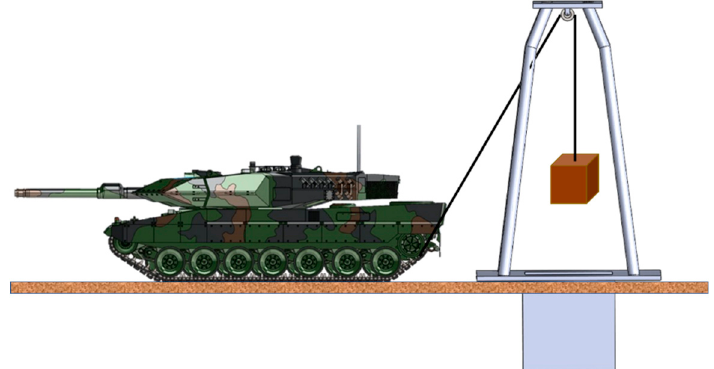
Figure 2. Schematic for the installation for measuring the moments of inertia of the transmission of a tracked vehicle, using the gravitational method.